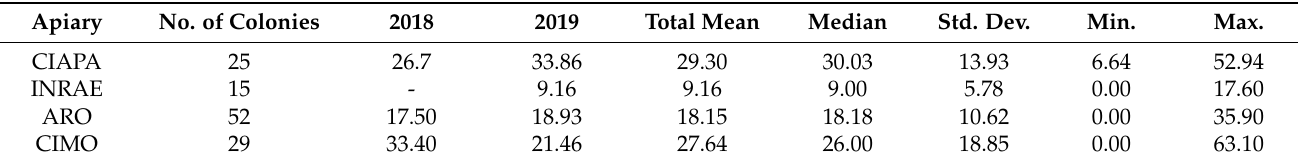
Table 6. Average honey production per colony (in Kg) at each apiary during the study period. Islands are not included. Data not